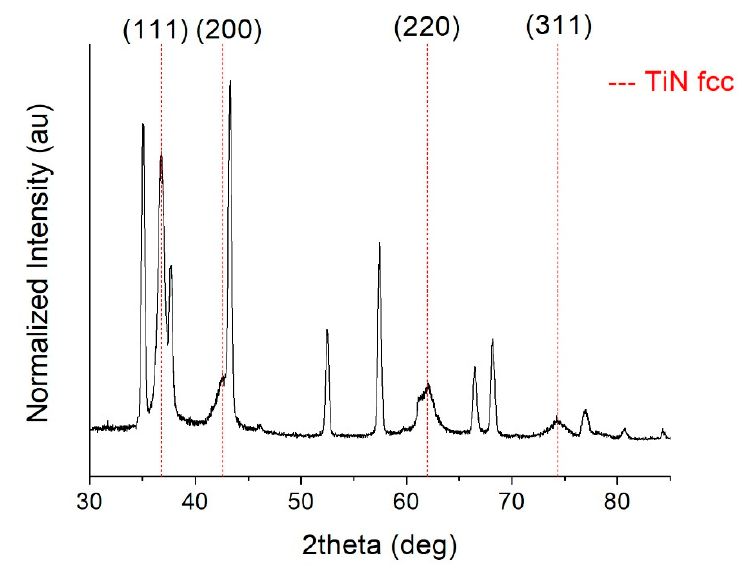
Figure 6. TiN4A XRD spectrum acquired using the grazing angle configuration.